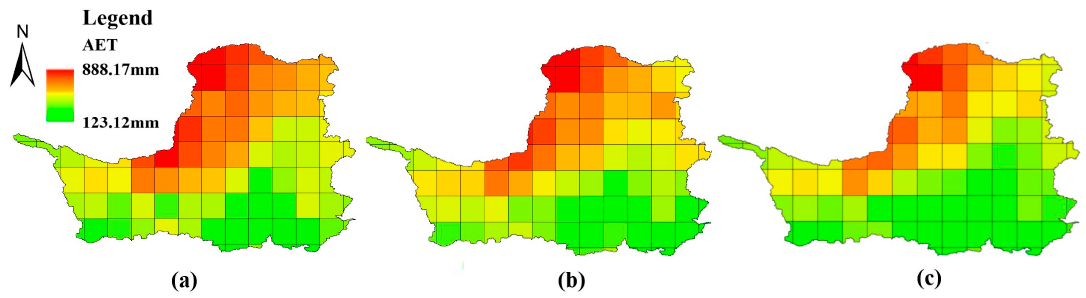
Figure 4. The spatial distribution of the AAP in three stages: ( a ) the spatial distribution of AAP in the initial stage after the Grain for Green Project launched (2003–2006), ( b ) the spatial distribution of the AAP in the middle stage after the Grain for Green Project launched (2007–2010), and ( c ) the spatial distribution of the AAP in the late stage after the Grain for Green Project launched (2011–2014).